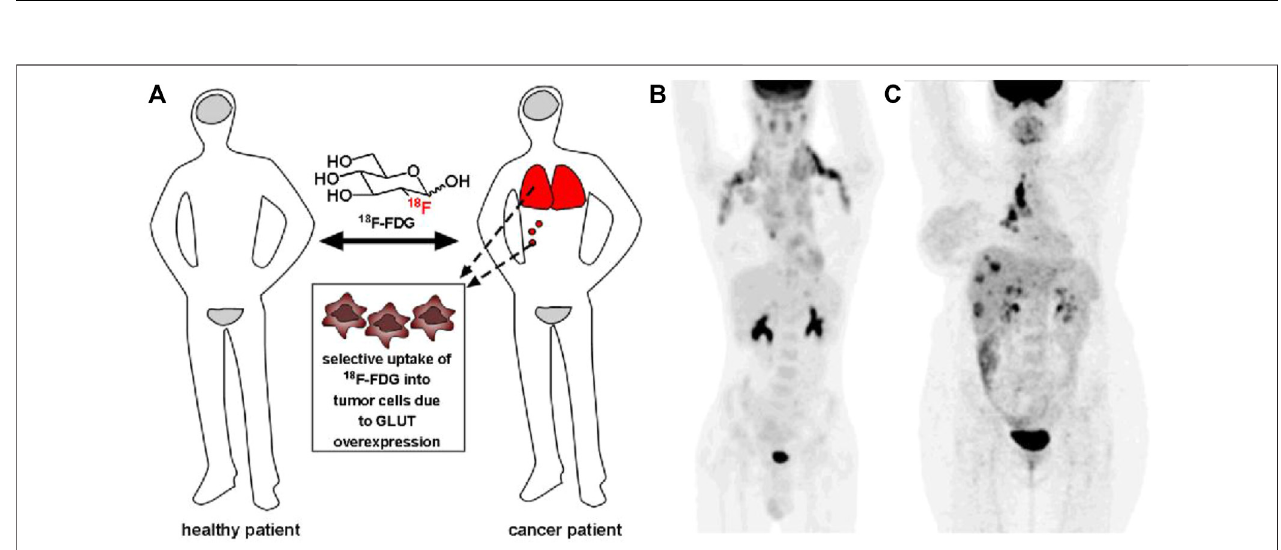
FIGURE 2 | (A) Since 18 F-FDG is preferentially uptaken by tumors, it is used to identify tumor sites and metastases (red). (B) 18 F-FDG positron emission tomography (PET) imaging of a patient with metastatic Hodgkin lymphoma. (C) 18 F-FDG PET imaging of a patient with metastatic breast cancer. Reprinted with permission from Calvaresi and Hergenrother (2013). Copyright 2013 Royal Society of Chemistry.